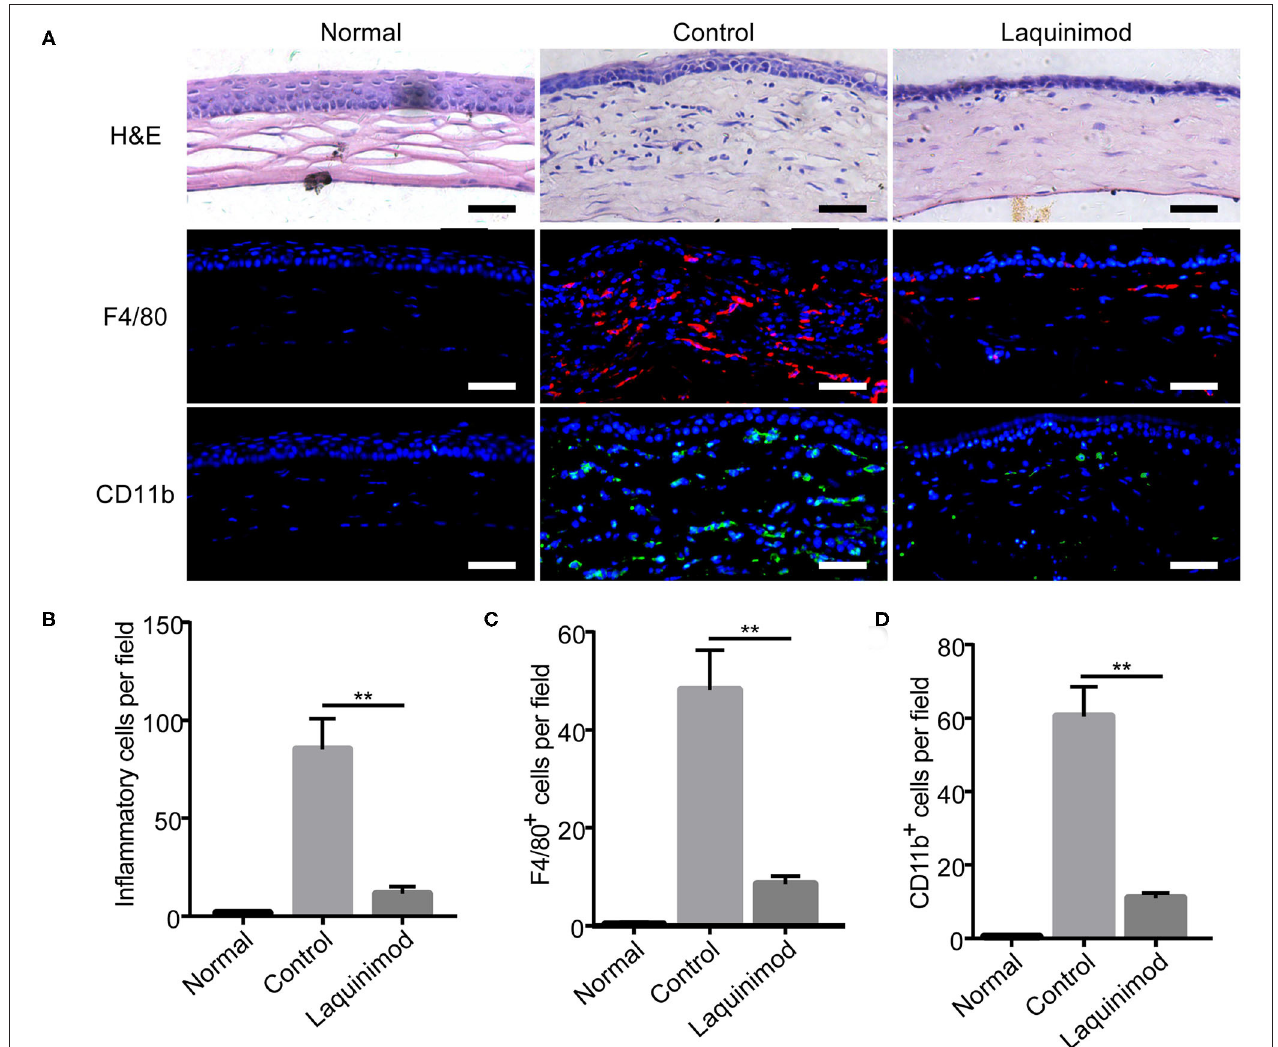
FIGURE 2 | Topical laquinimod application inhibited inflammatory cells and F4/80- or CD11b-positive cells in injured corneas. Five microliters of laquinimod was topically applied to alkali-injured corneas twice a day. (A) The eyes were harvested on the 7th day after alkali injury. H&E-stained sections were obtained, and the number of inflammatory cells in the central region of each burned cornea was determined. Frozen OCT sections from treated corneal tissues were stained with an anti-F4/80 or anti-CD11b antibody. Scale bars = 50 µ m. (B–D) Quantitative analysis of the data presented in (A) . ( n = 6). PBS as control, ** p < 0.01, laquinimod vs.